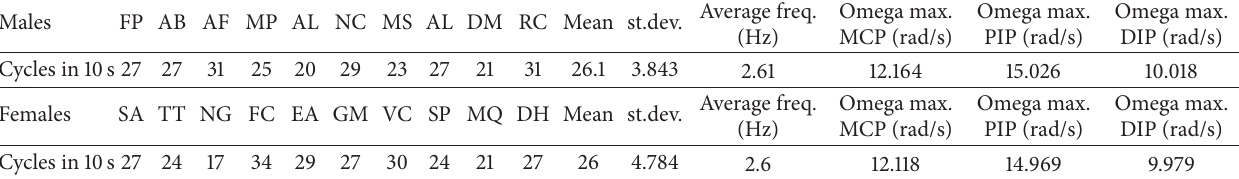
Table 9: Joint velocity tests.